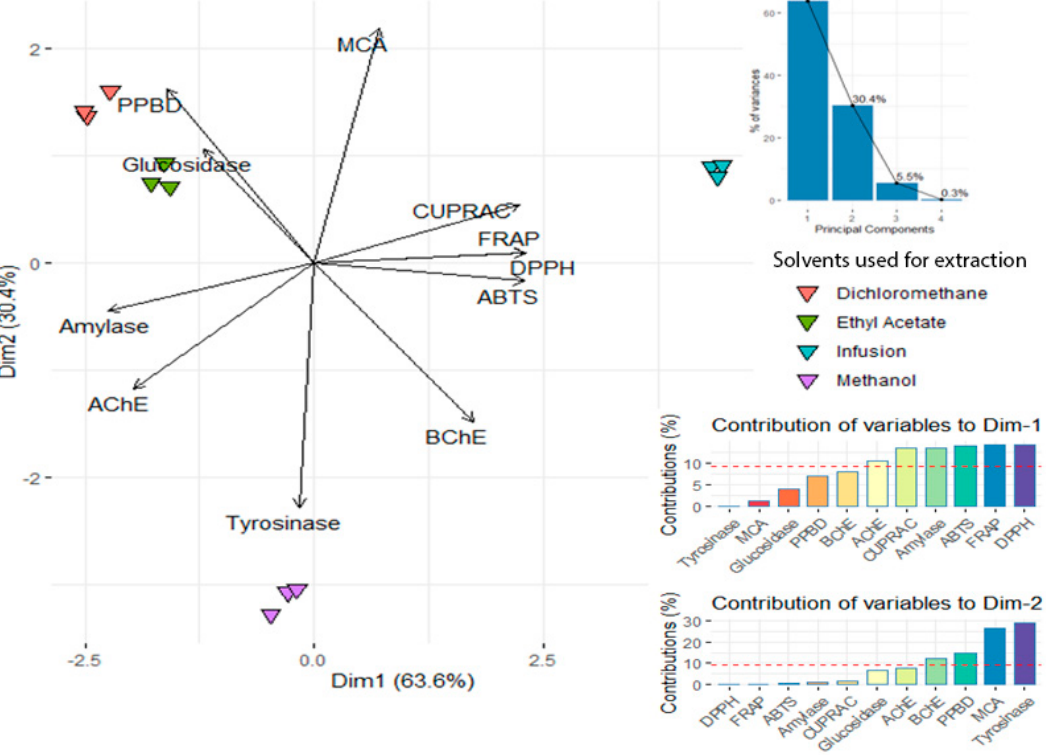
Figure 3. Unsupervised multivariate analysis with principal component analysis on A. aspera biological activities.